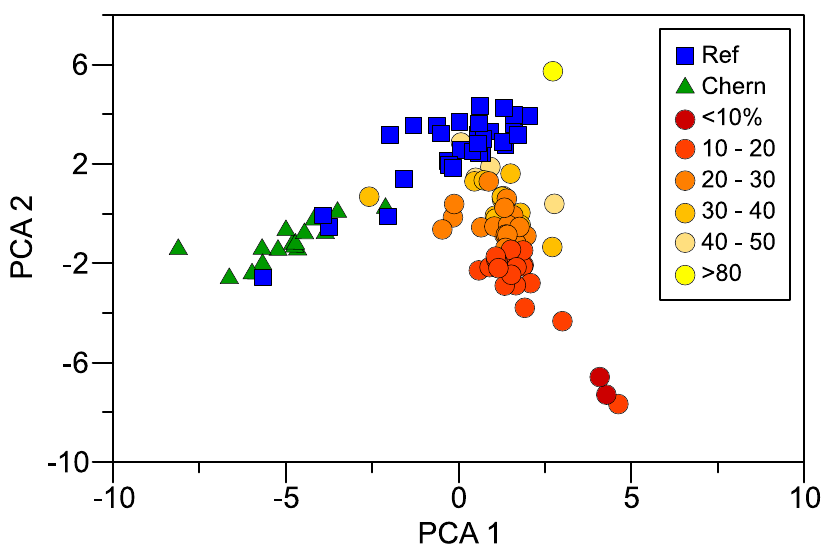
and Chernofski Harbor with triangles (green). Oiled results are color coded by percent naphthalenes, a measure of weathering. The most weathered samples have the least naphthalene.